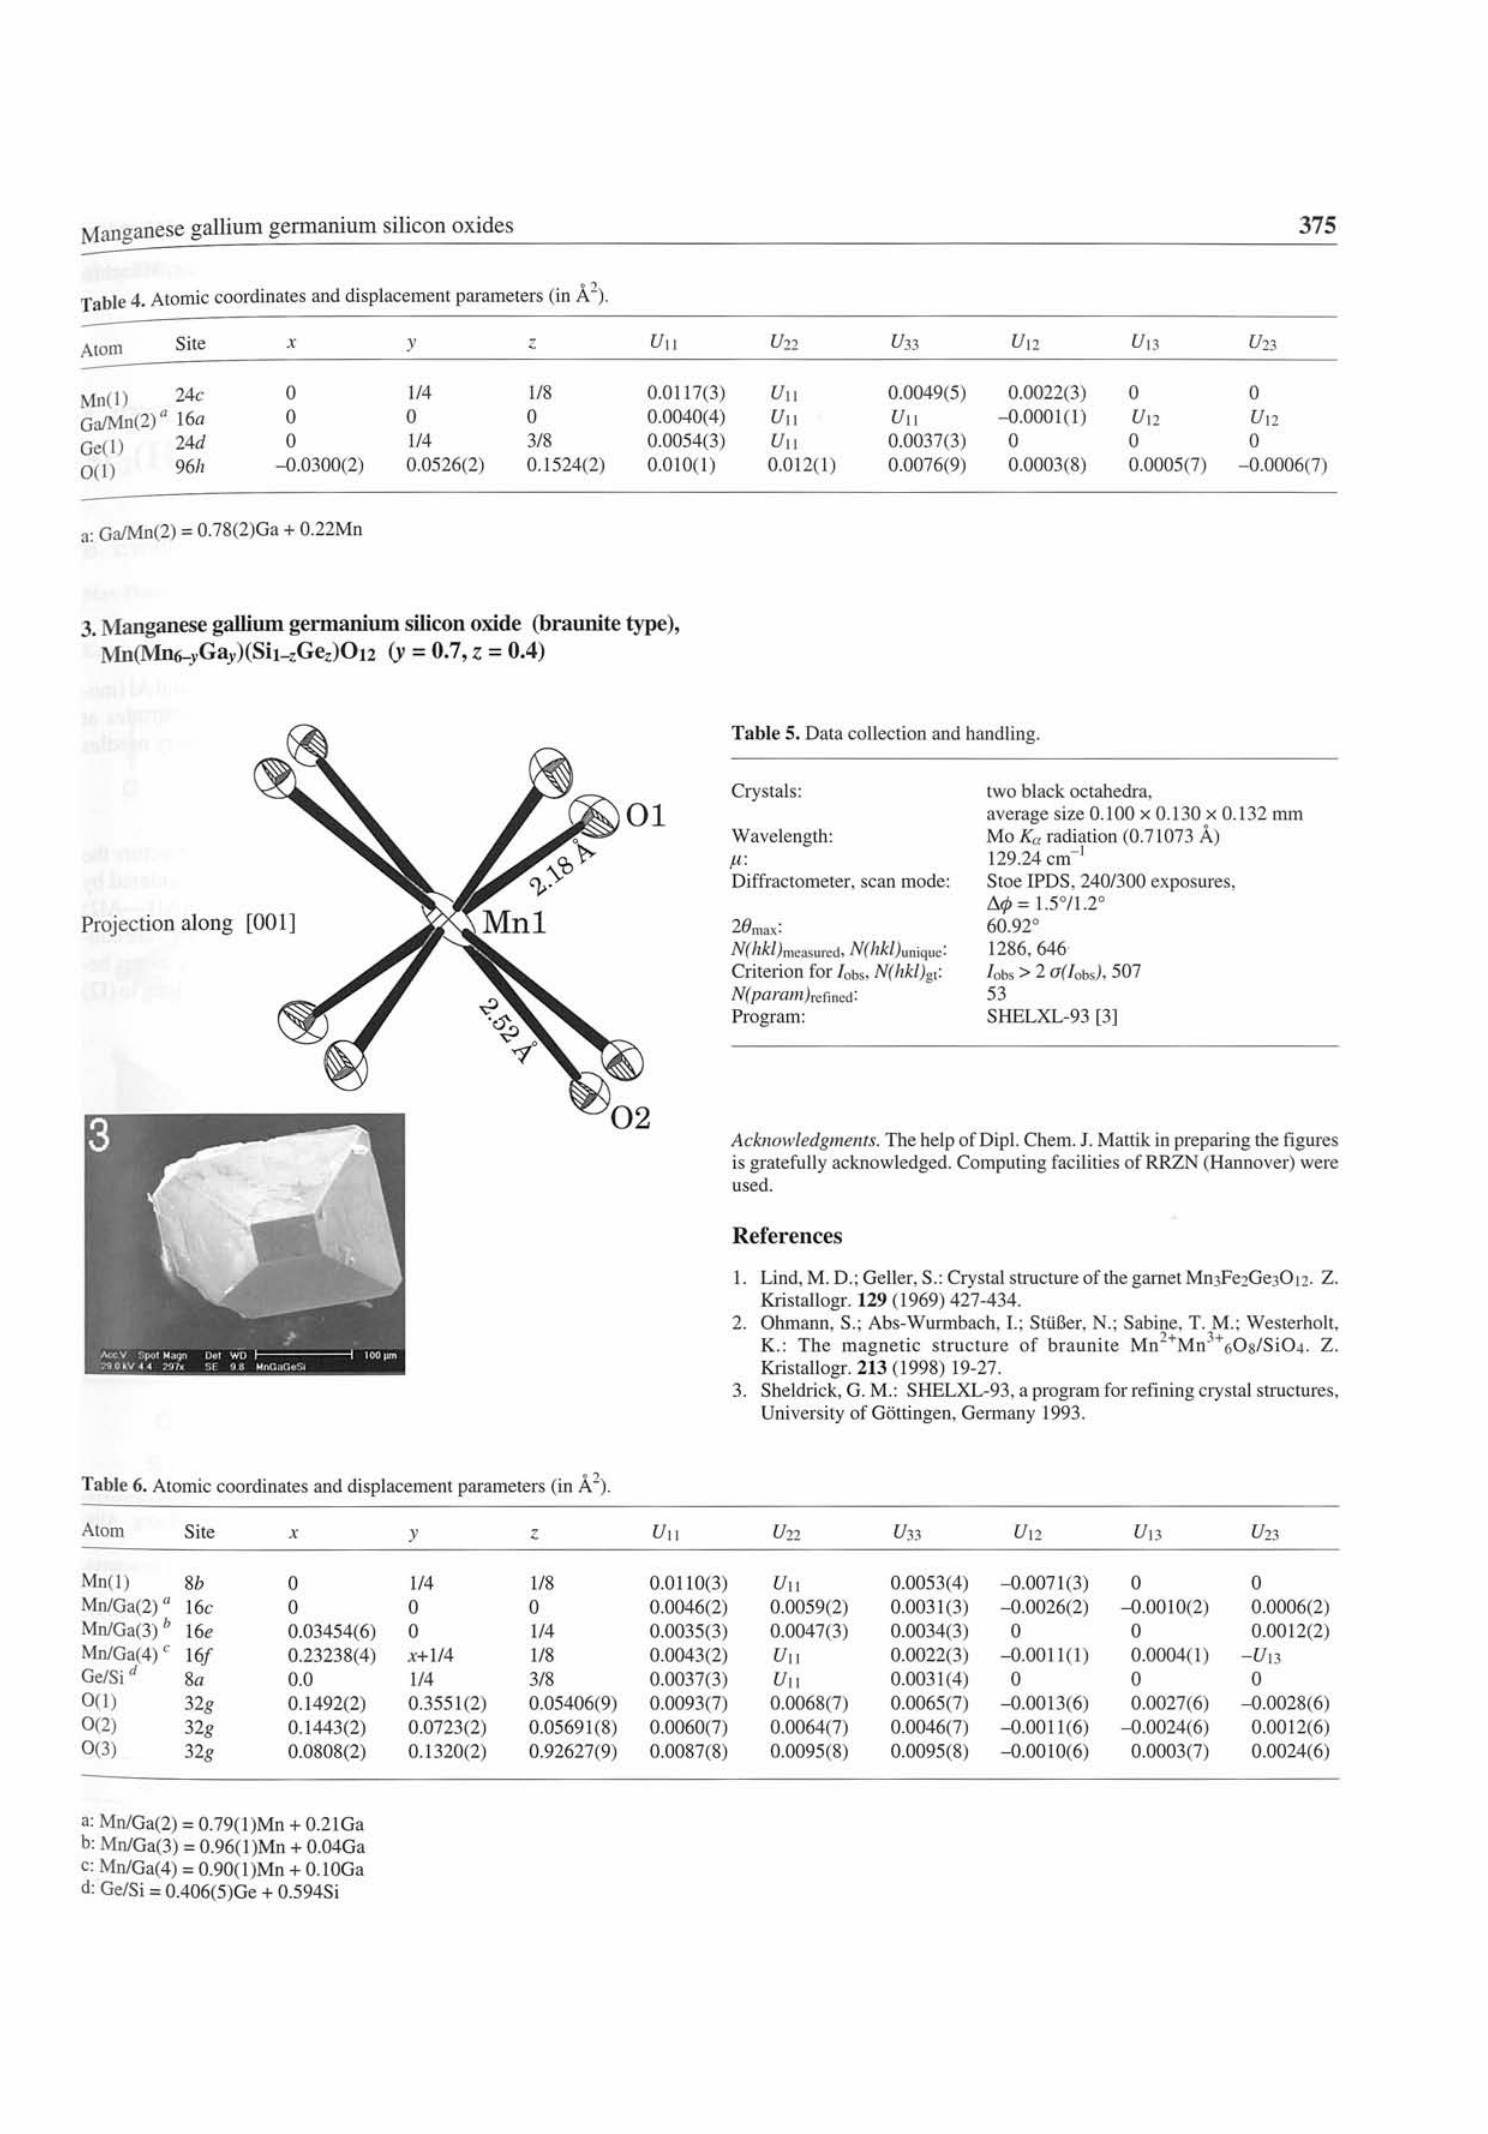
Table 4. Atomic coordinates and displacement parameters (in Â").